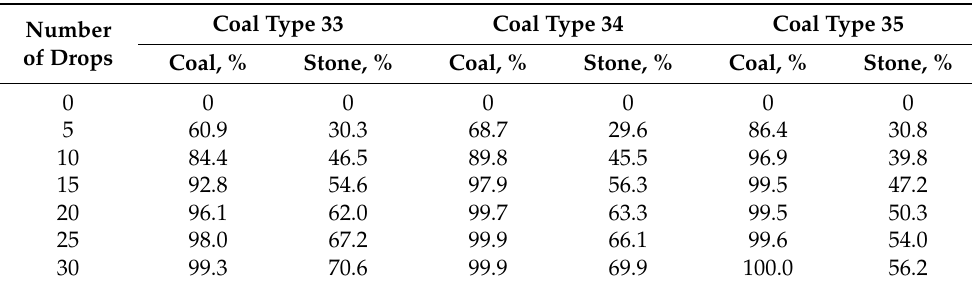
Table 4. Output of 80-0 mm size class depending on the drops number—comparative results for different coal types